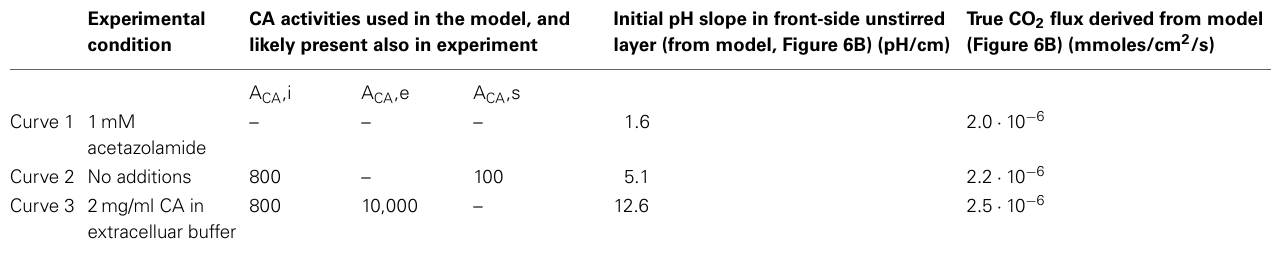
Table 2 | Summary of the conditions in the experiments with MDCK monolayers by Zocher et al. (2012) and in the model of Figure 5.